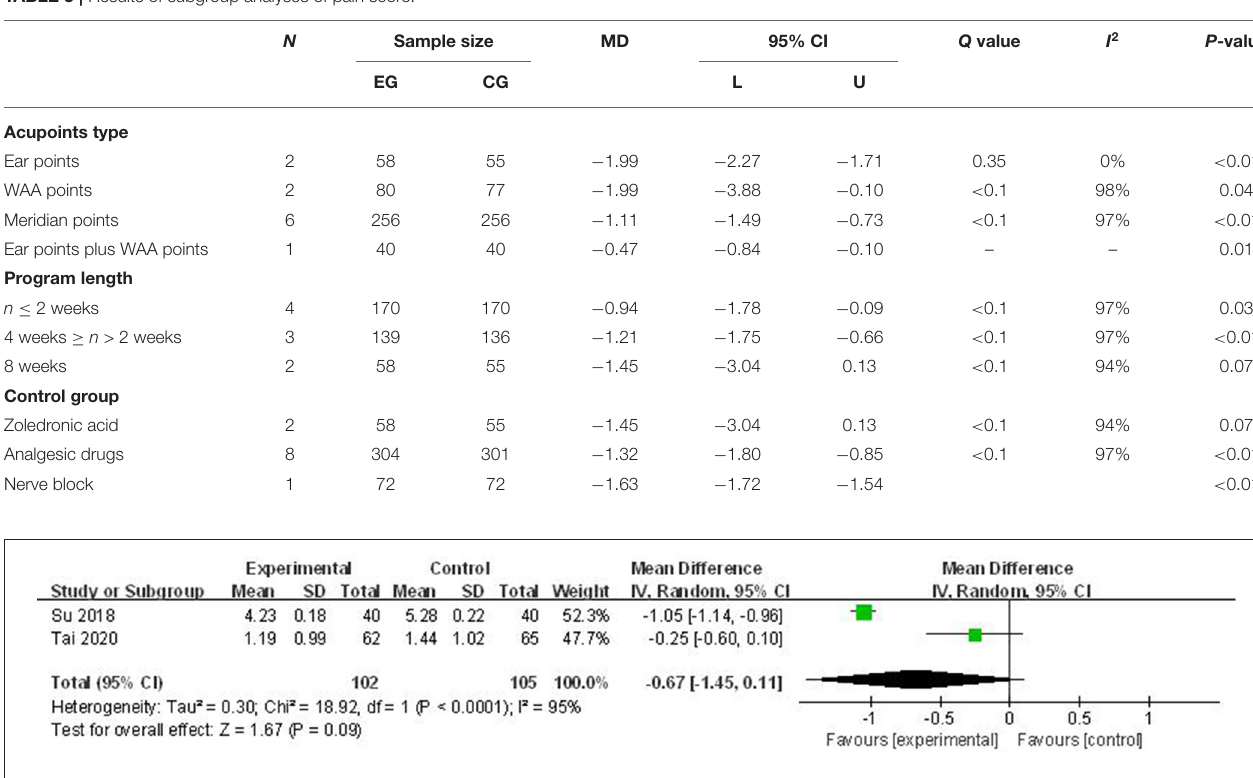
FIGURE 4 | Forest plots of acupuncture alone vs. control treatment: pain